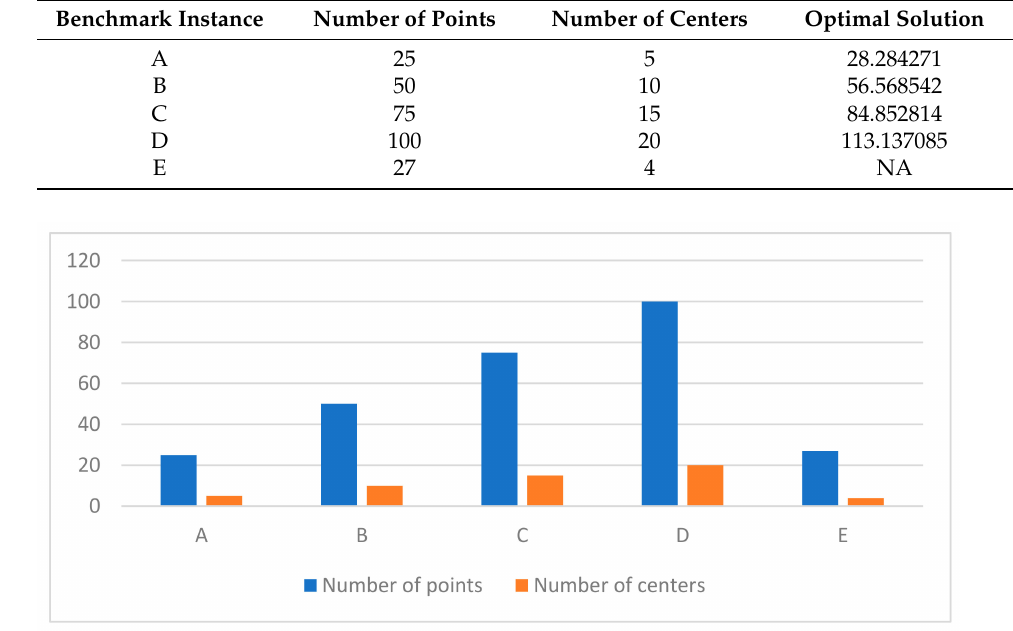
Figure 3. Graphical comparison of benchmark